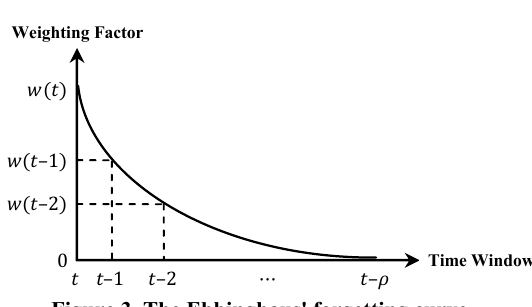
Figure 3. The Ebbinghaus' forgetting